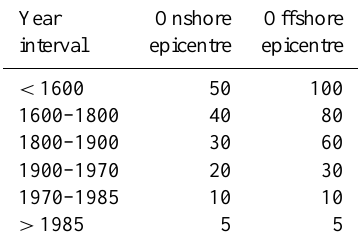
Table 1. Uncertainties (km) in epicentre